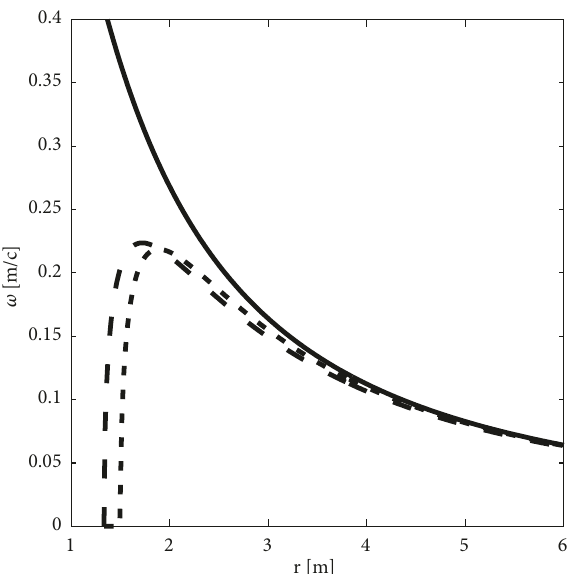
Figure 1: The orbital frequency of a particle in a circular orbit for the case GR (upper curve) and for 𝑛 = 3 (long dashed curve) and 𝑛 = 4 (short dashed curve) [12,